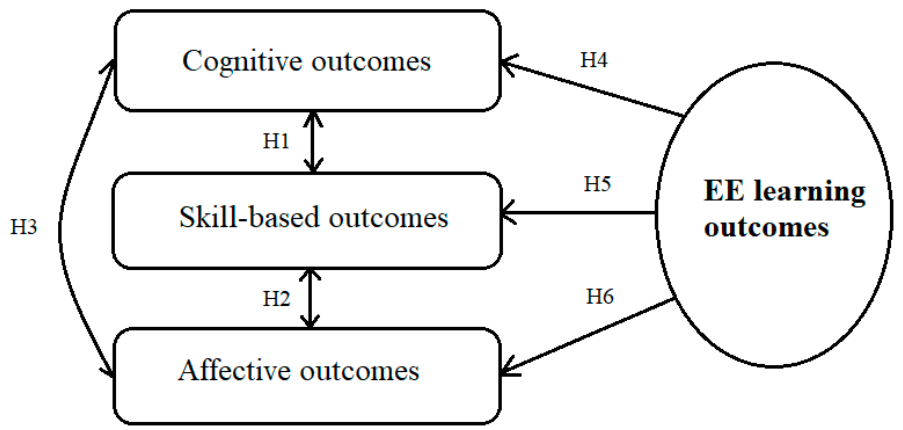
Figure 1. Conceptual framework of the study.